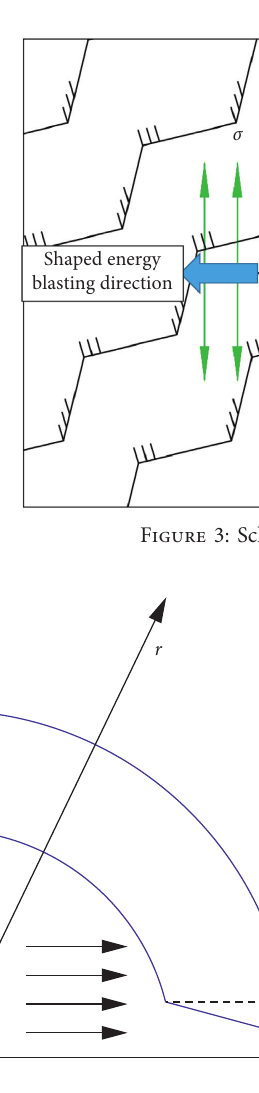
Figure 4: Quasistatic pressure map of explosive